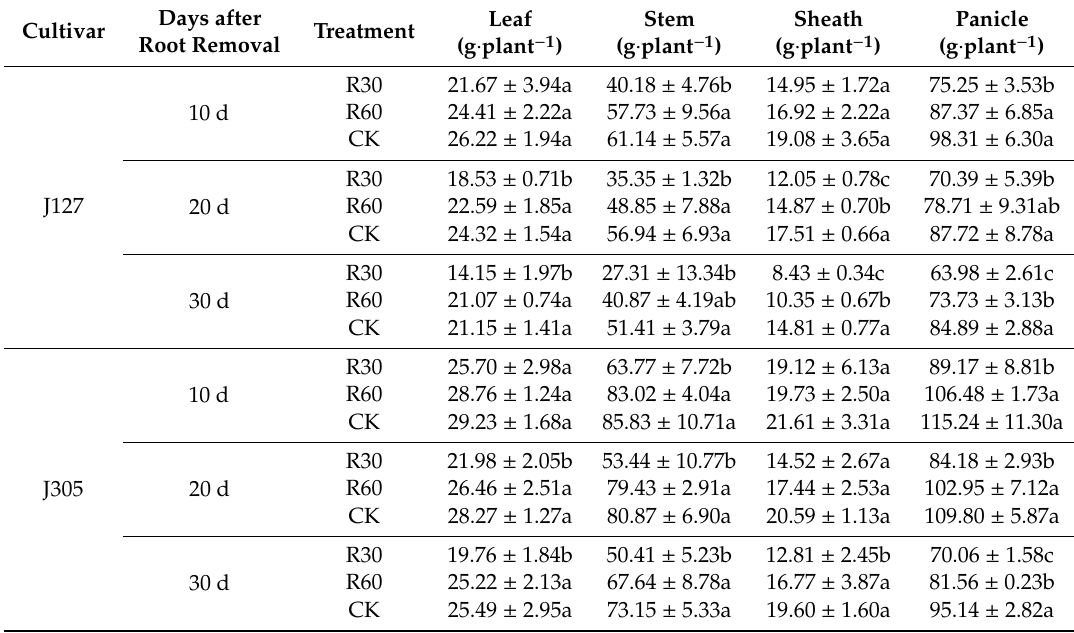
Table 3. E ff ects of root removal in di ff erent soil depths on dry matter accumulation. Cultivar